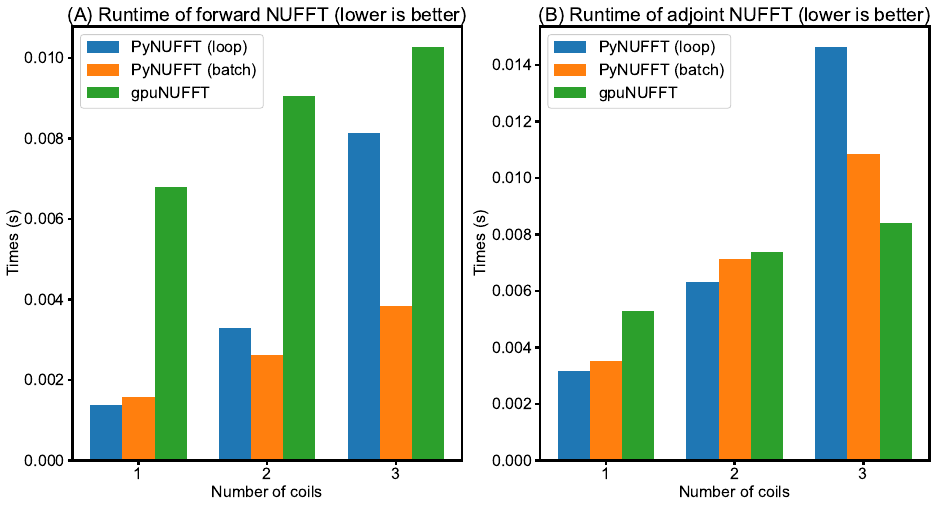
GPU implementations. In forward NUFFT, the fastest is the PyNUFFT (batch), followed by PyNUFFT (loop) and gpuNUFFT.